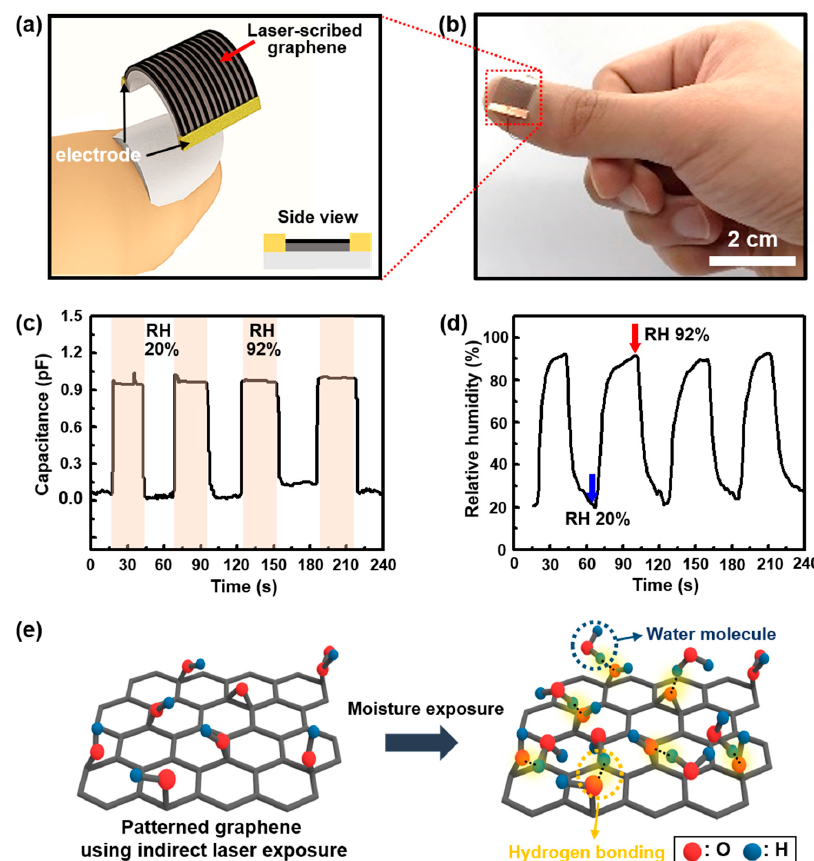
Figure 6. Schematic view ( a ) and digital image ( b ) of the laser-scribed rGO-based flexible humidity sensor attached on a nail (e.g., press-on nail wearable sensor), consisting of an indirect laser-scribed rGO film on flexible PP substrate integrated with a copper electrode. ( c ) The real-time signal responses as measured cyclic capacitance changes from the LDW GO-based humidity sensor, exposed to RH in the range of 20% to 92% at 30 s intervals. ( d ) The monitored RH changes collected from the real-time data logger correspond to the graph in ( c ). ( e ) Schematic drawing of absorption process of water molecules by hydrogen bonding on the partially reduced GO surface after moisture exposure.